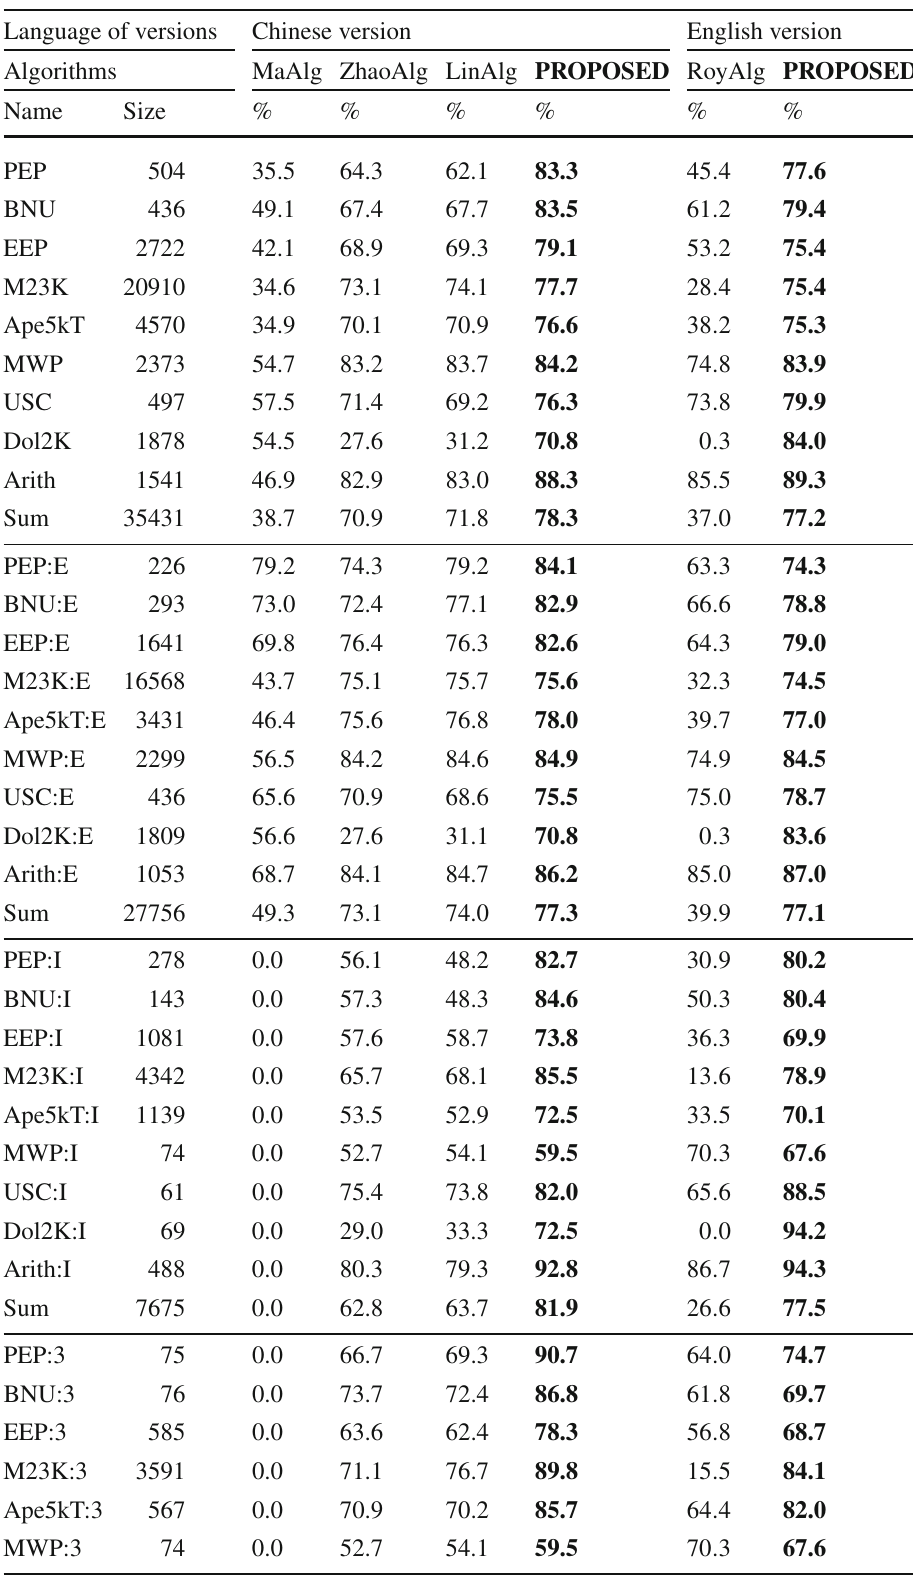
Table 4 The analytical comparison on the accuracy of solving problems considering PROPOSED against the four baseline algorithms on the nine